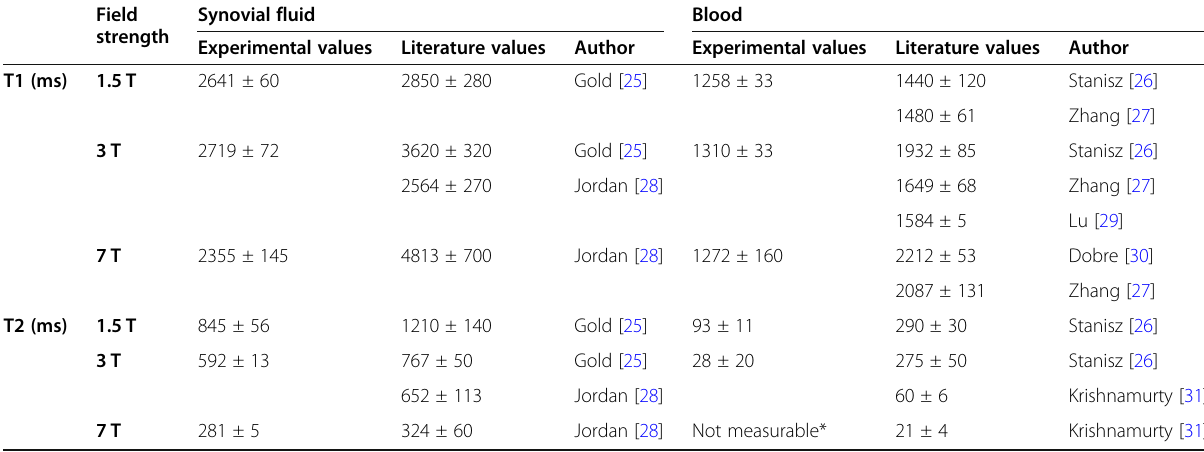
Experimental values Values measured in this study in region of interests within the synovial fluid (0% blood) and 100% blood tubes reported as means and standard deviations, Literature values Mean values found in other studies with corresponding standard deviations, *T2 times too short to be